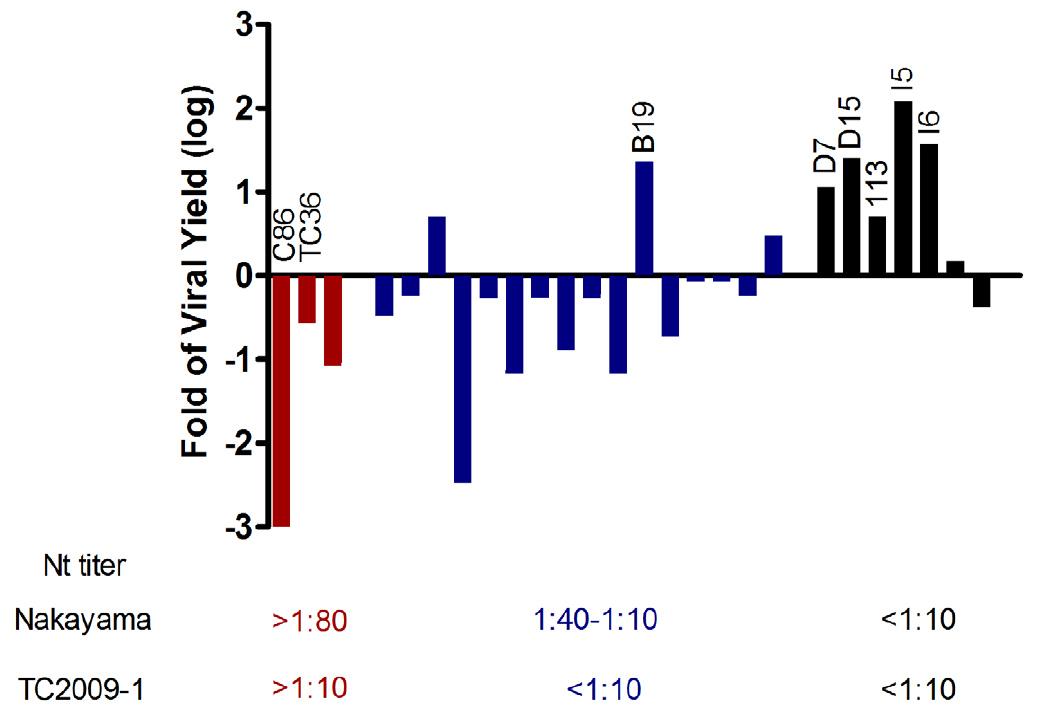
Figure 3. Effects of children’s undiluted serum samples on viral yield of GI JEV from K562 cells. The magnitude of enhancement of viral yield is calculated as follows: Log 10 (serum-treated viral titer/untreated viral titer). The K562 cells infected with labeled samples C86, TC36, B19, D7, D15, 113, I5 and I6, were subjected to infection rate analysis by flow cytometry (Figure 4).